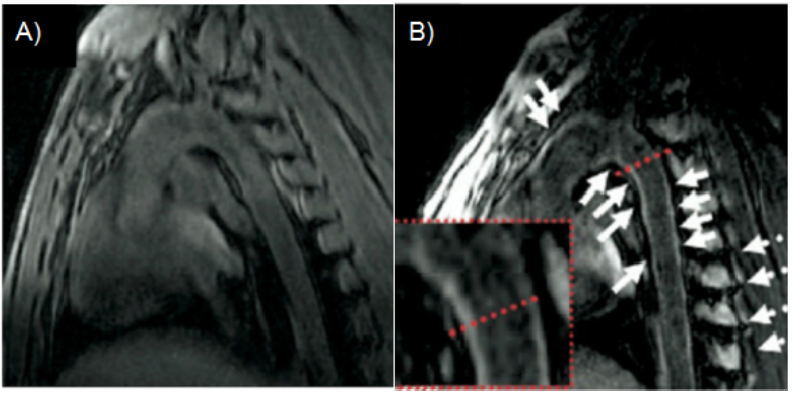
Figure 8. Imaging of macrophage burden using an off-resonance imaging sequence (IRON, inversion recovery with ON-resonant water suppression). ( A ) Before the injection of MION tissue is homogeneously suppressed using the IRON sequence. ( B ) 48 h after the injection of MION, intraplaque iron oxide particles generate areas of positive contrast on IRON images, which were in good agreement with areas of iron deposition on corresponding histological slices. The magnitude of positive signal enhancement correlated with the number of macrophages determined by histology. MION: Magnetic iron oxide nanoparticle (adapted from Korosoglou)